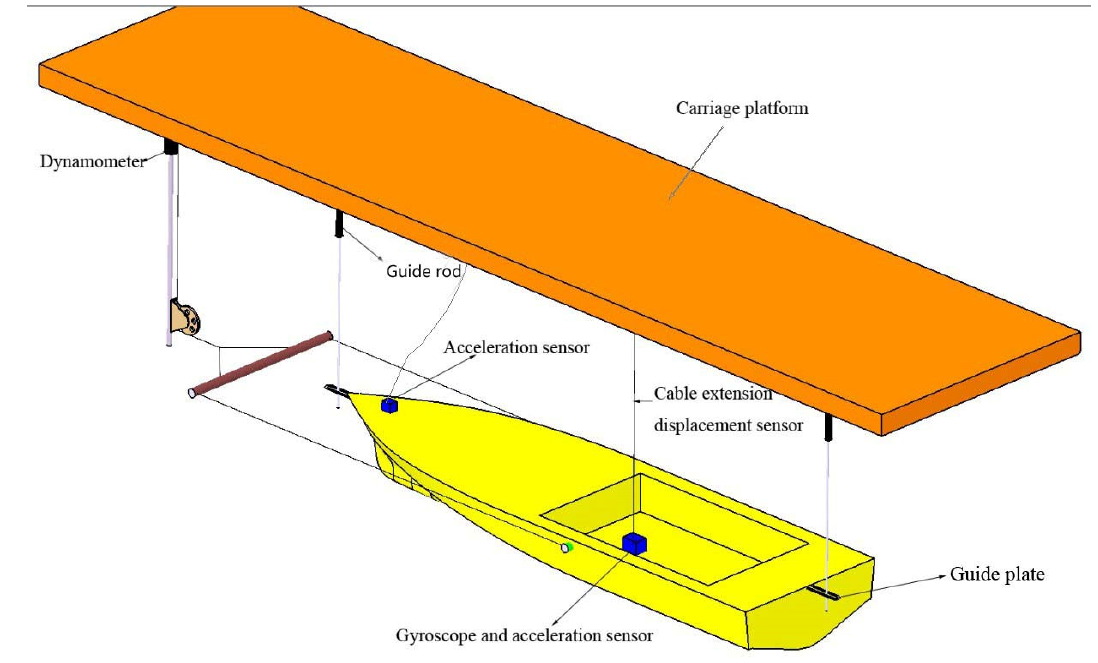
Figure 3. Experimental setup.